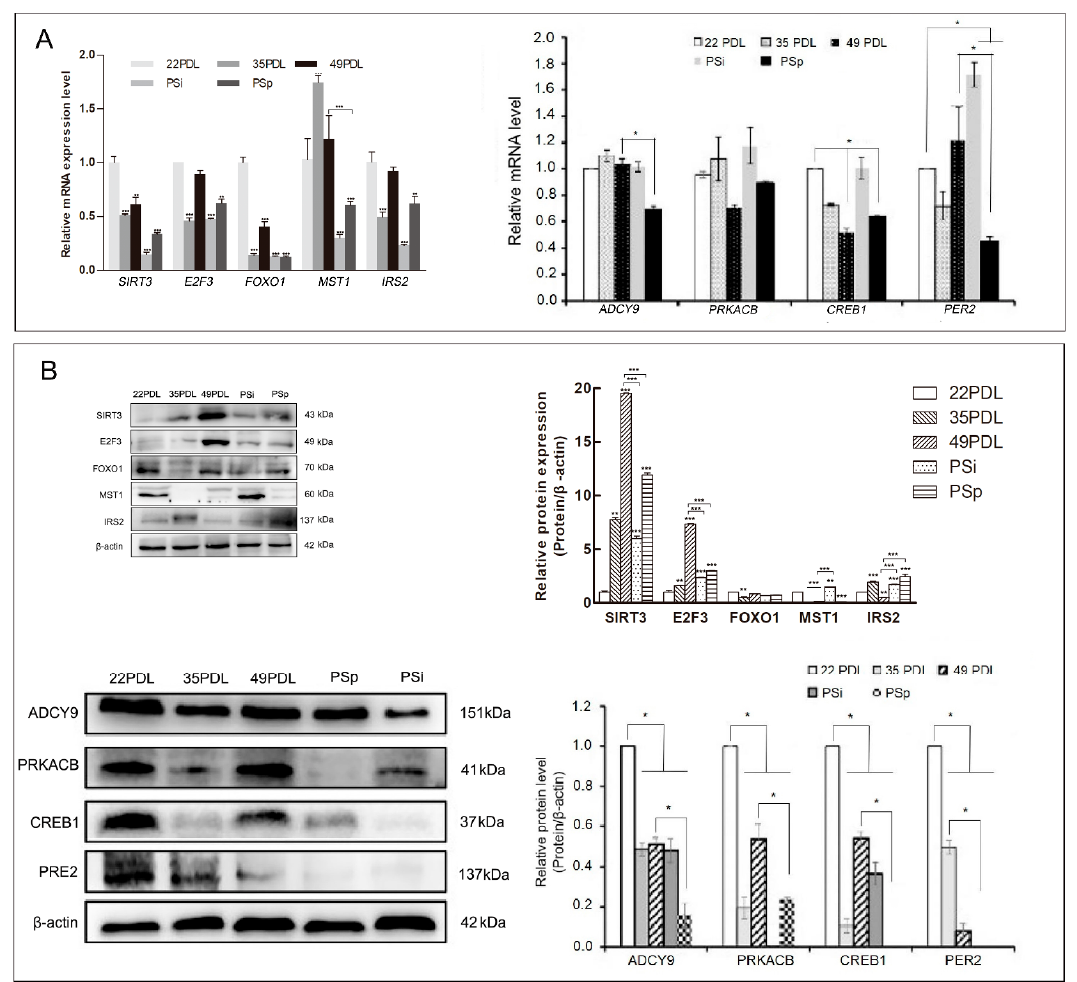
Figure 5. Expression of candidate genes related to senescence. ( A ) The mRNA expression of senescence-related genes. ( B ) Western blotting analysis for candidate genes related to senescence and protein level quantification. The data are presented as the mean ± SEM ( n = 3). Compared with the 22PDL or 49PDL group, * p < 0.05, ** p < 0.01, or *** p < 0.001.